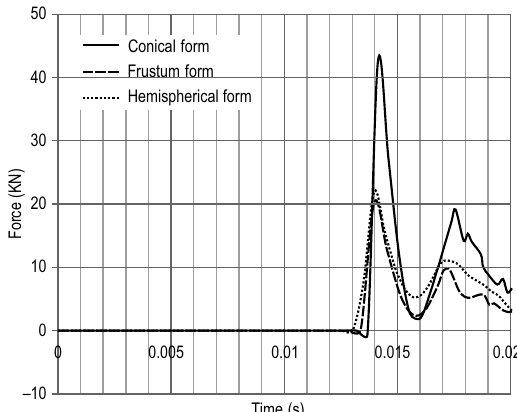
Fig. 4. The comparison of types of building shapes due to explosion in the height of 12